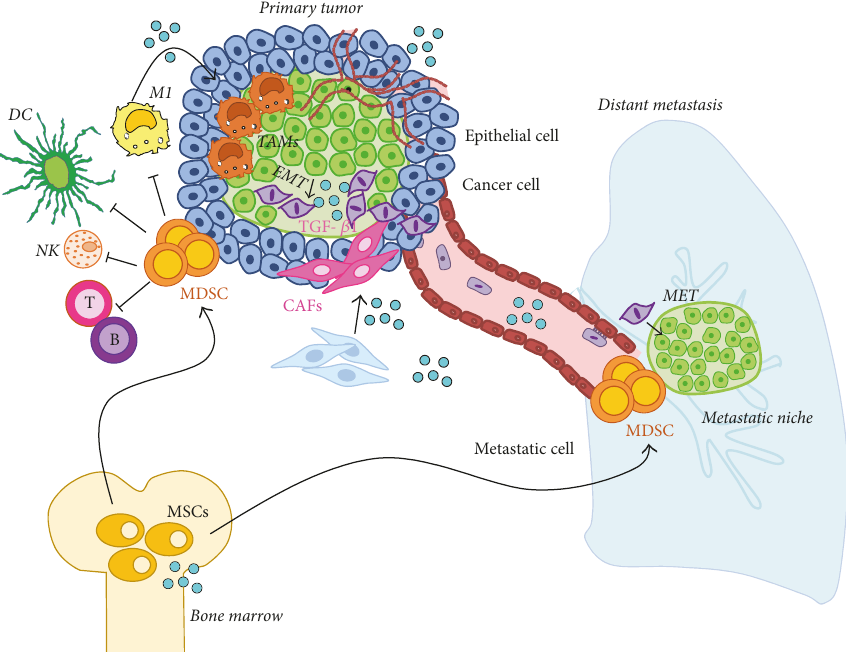
Figure 5: Tumor-promoting functions of OPN. OPN (blue sphere) induces increased proliferation and survival of tumor cells; it is also associated with the recruitment of myeloid-derived suppressor cells (MDSC), from bone marrow stem cells. MDSC create an immunosuppressive niche both in the primary tumor and in the metastatic tissue, thereby creating a favorable place for tumor growth. OPN favors dissemination and angiogenesis to counteract hypoxia, and concomitantly reprograms tissue fi broblasts to cancer-associated fi broblasts (CAFs), which by secreting TGF- β 1, promote epithelial to mesenchymal transition (EMT) allowing tumor cells to detach from the primary mass and disseminate to the premetastatic niche. Here, OPN promotes mesenchymal to epithelial transition (MET) favoring the metastatic